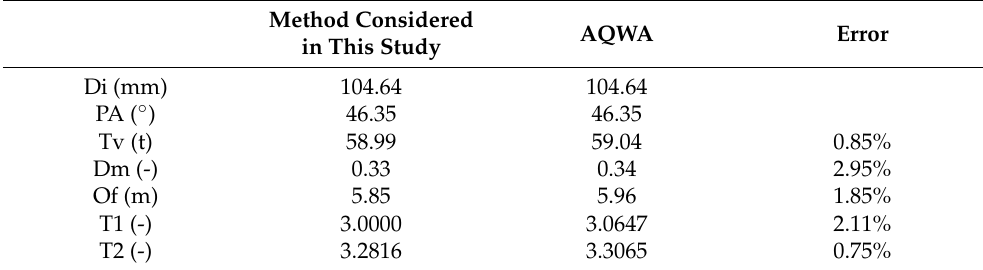
Table 4. Elliptic function adaptive sampling optimization